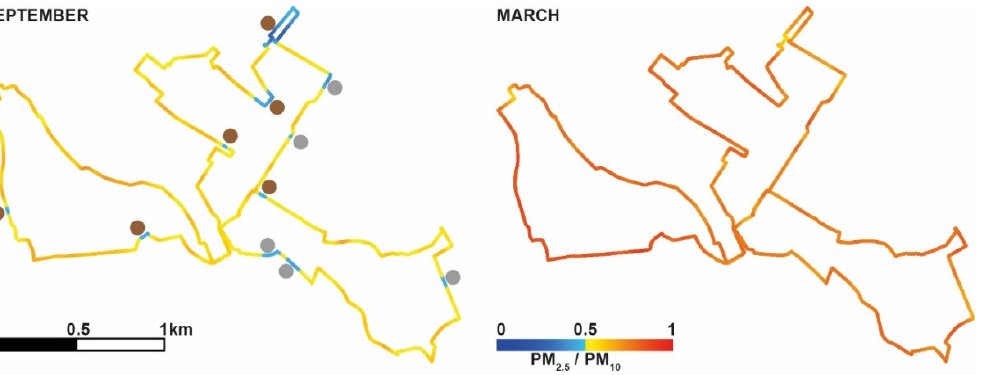
Figure 8. Spatial patterns of mean PM 2.5 /PM 10 ratios in September and March. Bluish colors indicate ratios between 0 to 0.5. The dots mark important particle sources including unpaved surfaces (brown) and construction sites (grey).